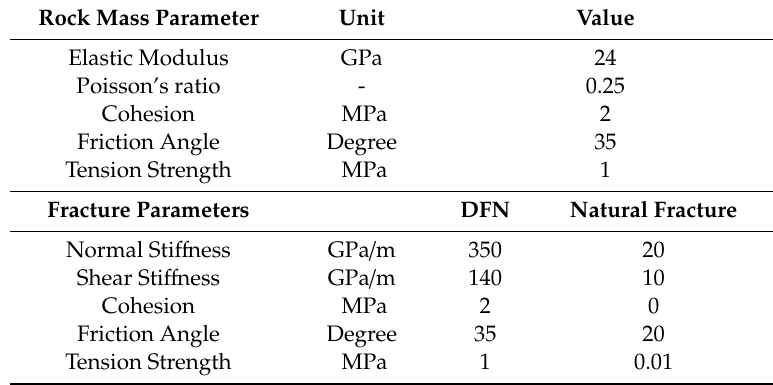
Table 1. Rock mechanical properties of rock mass, discrete fracture network (DFN), and natural